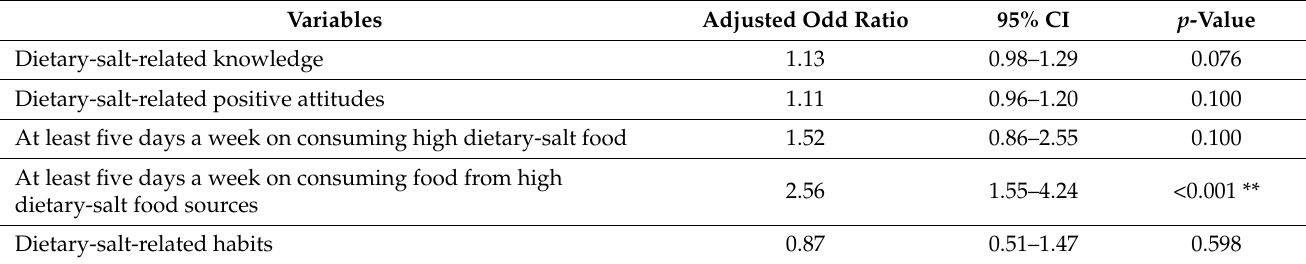
Table 8. Multivariate logistic regression for factors associated with